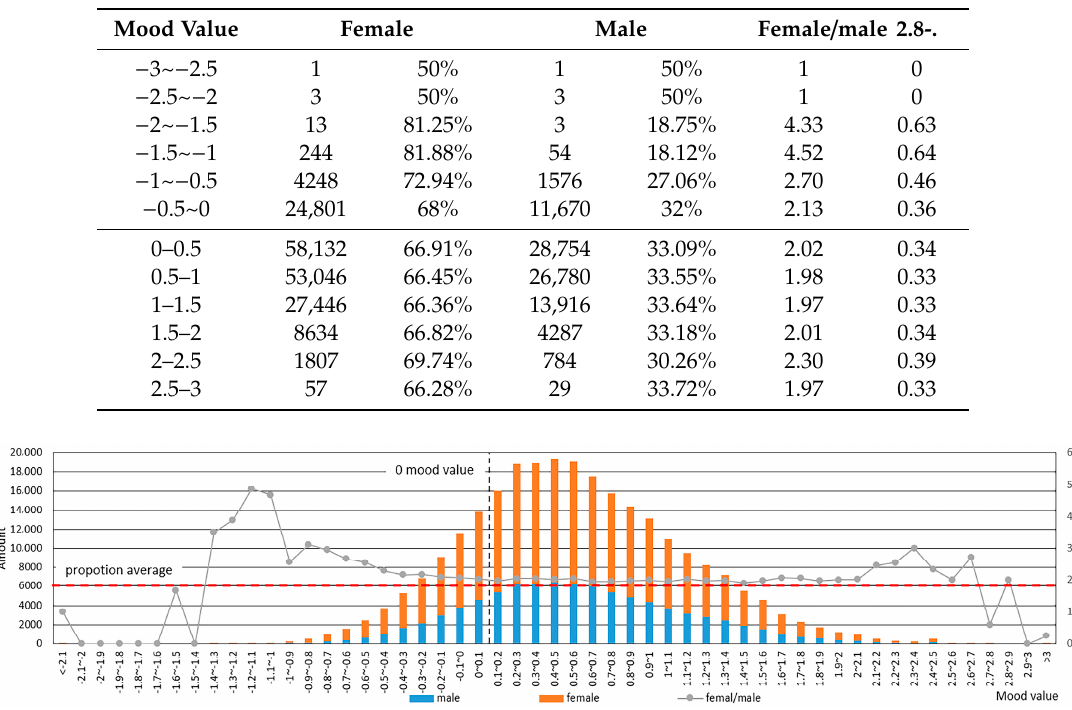
Figure 7. Emotional point ratios of women and men in different scores.